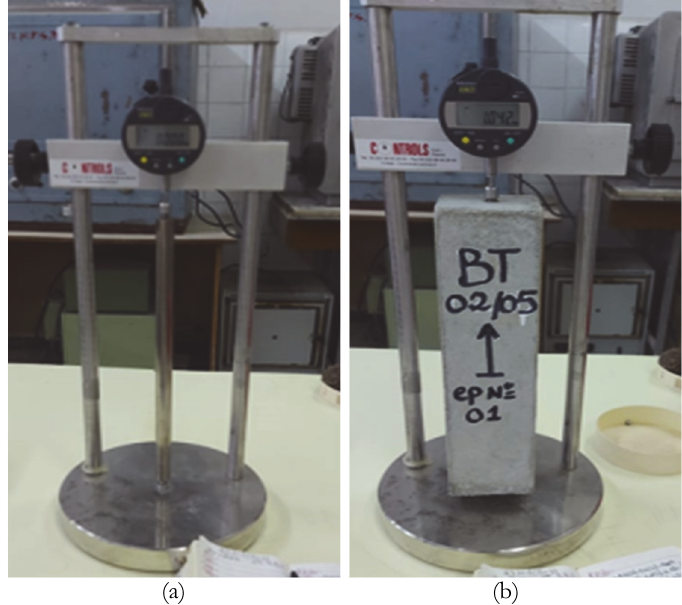
Figure 12: Shrinkage device: (a) retract-meter calibration and (b) shrinkage measurement.